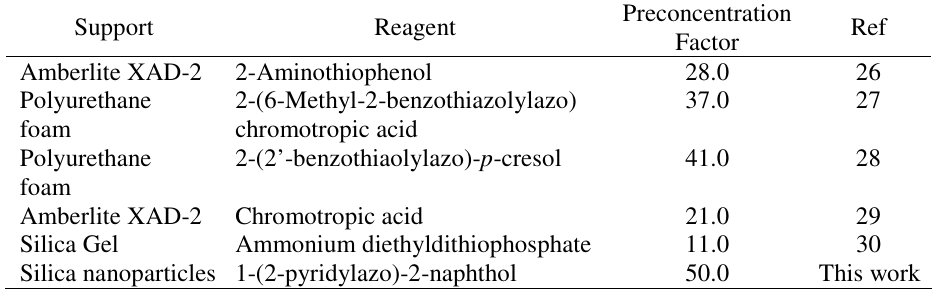
Table 5. Figure of merit of comparable methods for the determination of Cd(II) by solid- phase